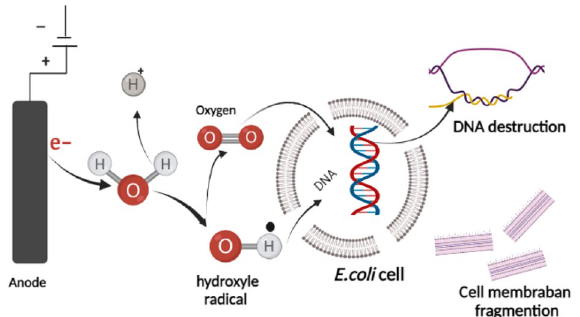
Figure 6. Proposed scheme of E. coli disinfection in the electrooxidation cell.